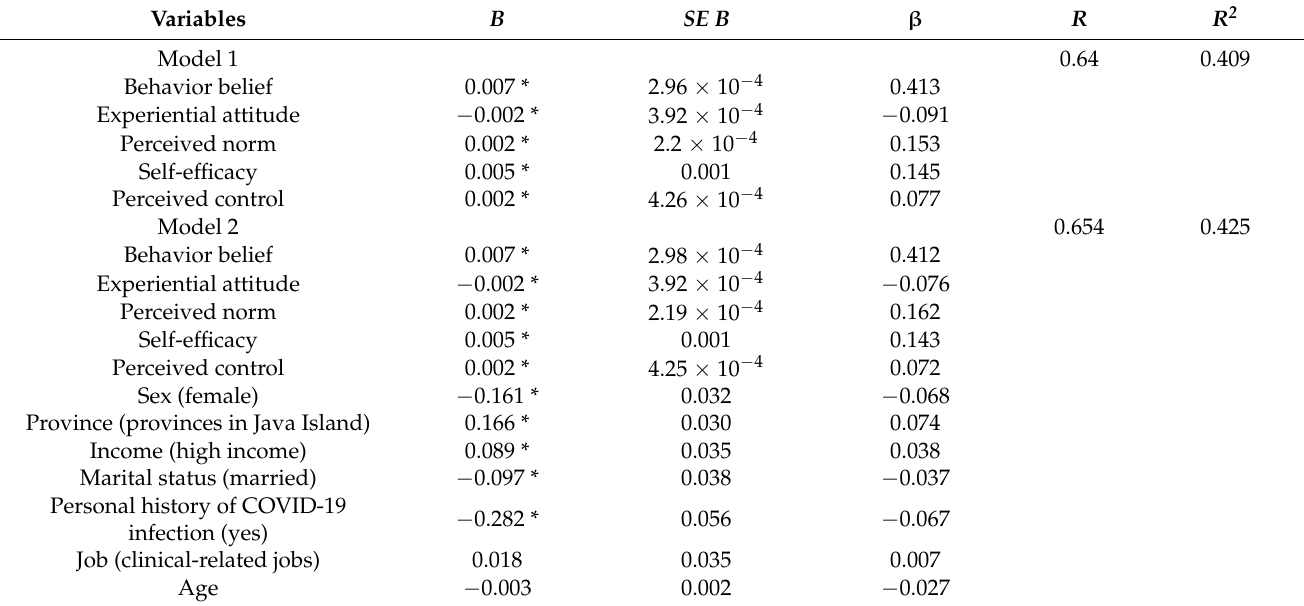
Table 3. Final regression